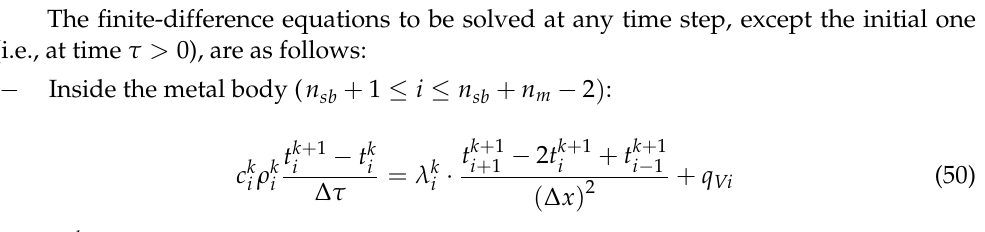
Figure 10. The design scheme for numerical calculation of the sheet temperature ( x is the axis along the thickness of the sheet). Designations are in the text.